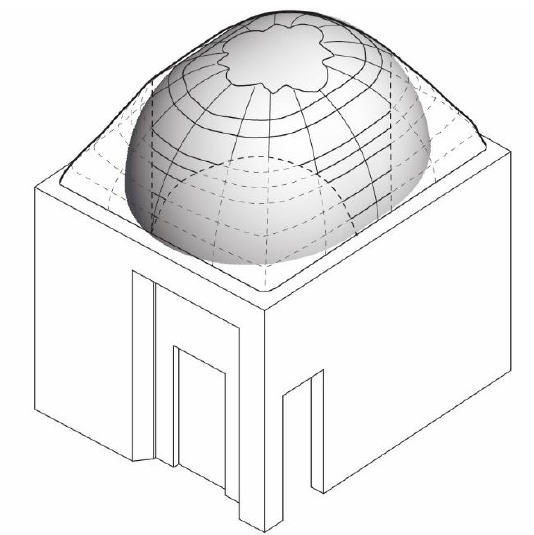
Figure 8. Axonometric view of horizontal and radial slicing of the vault obtained by point cloud of intrados defining a spherical